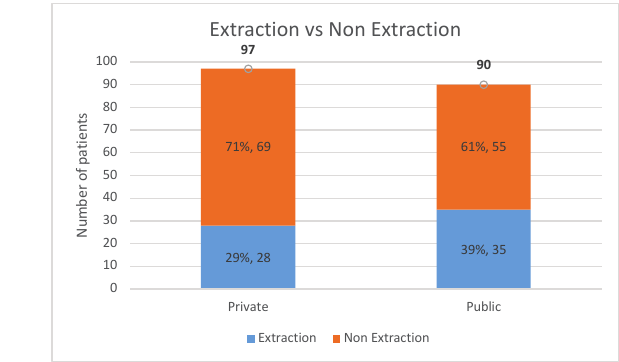
Figure 4. Extraction versus non-extraction in private compared to public